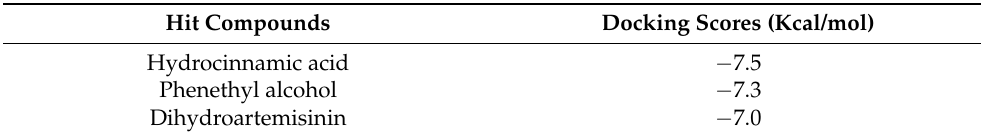
Table 1. The docking energy score of top three ligand molecules from both extracts. The AutoDock software was used for cross docking validation.